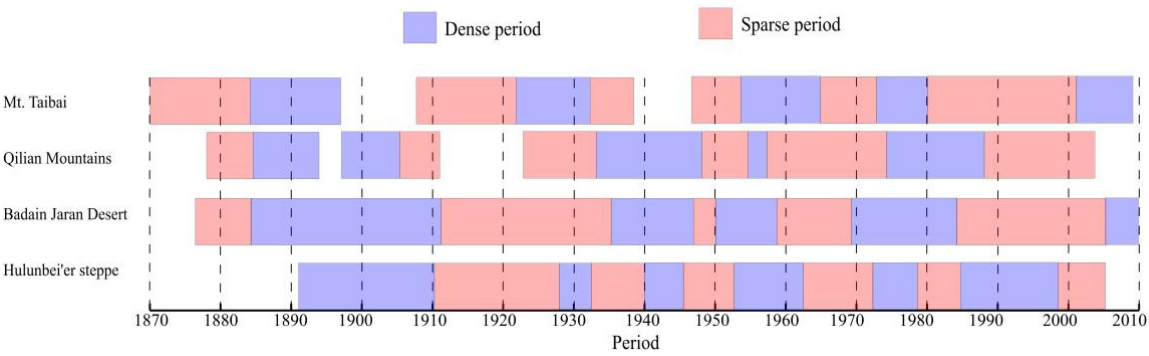
Figure 11. The dense and sparse periods of July NDVI in Mt. Taibai, June–August NDVI in the Qilian mountains [59], May–July NDVI in Badain Jaran Desert [61] and May–October NDVI in Hulunbei’er steppe [58].